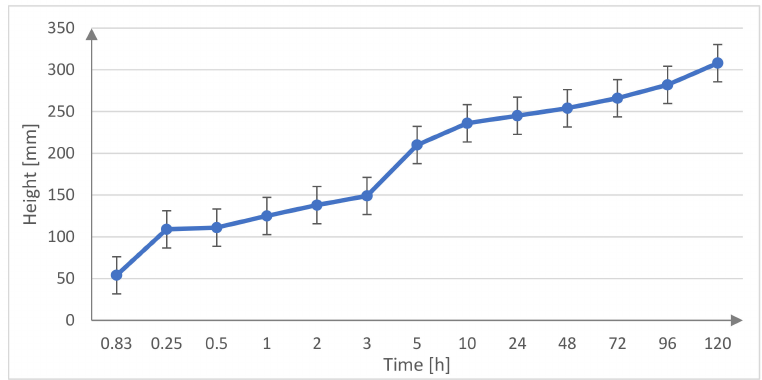
Figure 6. Capillary suction of the basalt fine aggregate in relation to